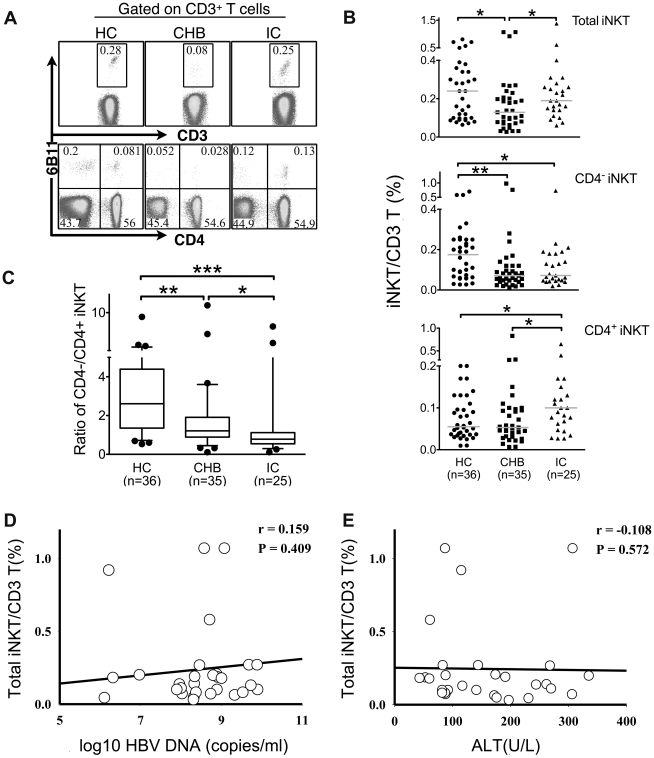
Peripheral invariant NKT (iNKT) cells decreased in CHB patients.Fresh isolated PBMC were stained with FITC-anti-CD3, APC-anti-CD4, and PE-anti-iNKT (6B11), which specifically recognizes the complementarity determining region 3 (CDR3) of the invariant Vα24-Jα18 T cell receptor (TCR) chain, and analyzed by flow cytometry. CD3+6B11+ dot plots indicated iNKT cells, and CD4 was used to determine the subsets of iNKT cells. (A) Representative dot plots of total, CD4− and CD4+ iNKT cells in peripheral blood from healthy controls (HC), CHB patients and inactive carriers (IC). (B) Pooled data of the frequencies of total, CD4− and CD4+ iNKT cells in three groups. Horizontal bars indicated the median value of each group. (C) The ratio of CD4−/CD4+ iNKT in HC, CHB and IC. Horizontal lines illustrated the 25th, 50th, and 75th percentiles. (D, E) Spearman correlation test showed that the frequencies of total iNKT cells in CHB patients (n = 30) had no correlation with HBV DNA and alanine transaminase (ALT) levels. * P<0.05, ** P<0.01, *** P<0.001, using the Mann-Whitney U test.